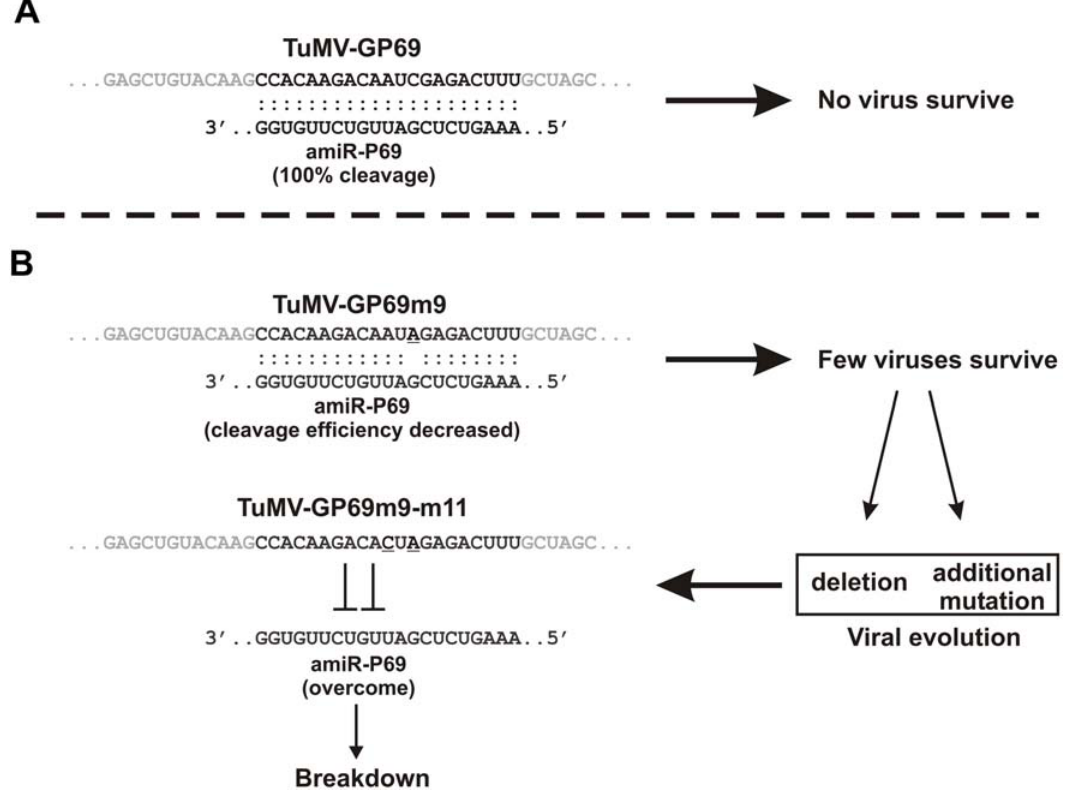
Figure 6. A working model to explain breakdown of amiRNA-mediated resistance by virus mutation. (A) Complete sequence complementarity between the 21-nt target site and the amiRNA. (B) TuMV-GP69m9 is a mutant virus with a single mutation (underlined) on position 9 of the target site. As this position is critical, the mutation causes a decrease in the cleavage efficiency of TuMV-GP69m9 viral RNAs, allowing some viral RNAs to escape the amiRNA-mediated surveillance. The surviving TuMV-GP69m9 virus rapidly undergoes evolution, collecting additional mutations on the target site. The next generation of mutated viruses with additional mutations can overcome the amiRNA-mediated resistance.